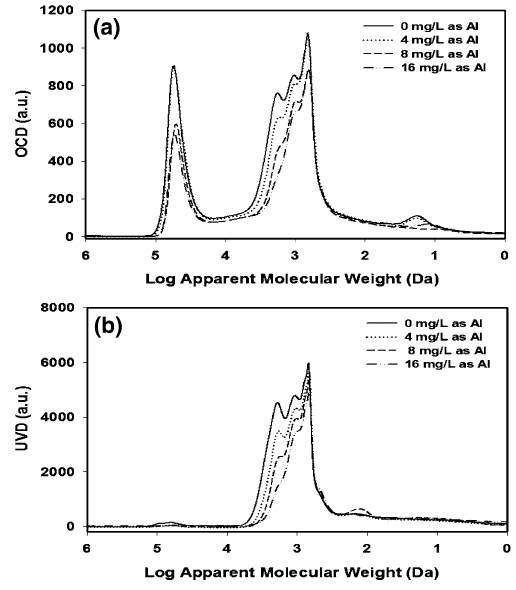
Fig. 6 a HPSEC-OCD and b HPSEC-UVD chromatograms of coagu- lated water under various alum dosages Table 3 The organic fractions’ removal by coagulation under various alum dosage using HPSEC-OCD chromatograms combined with peak-fitting